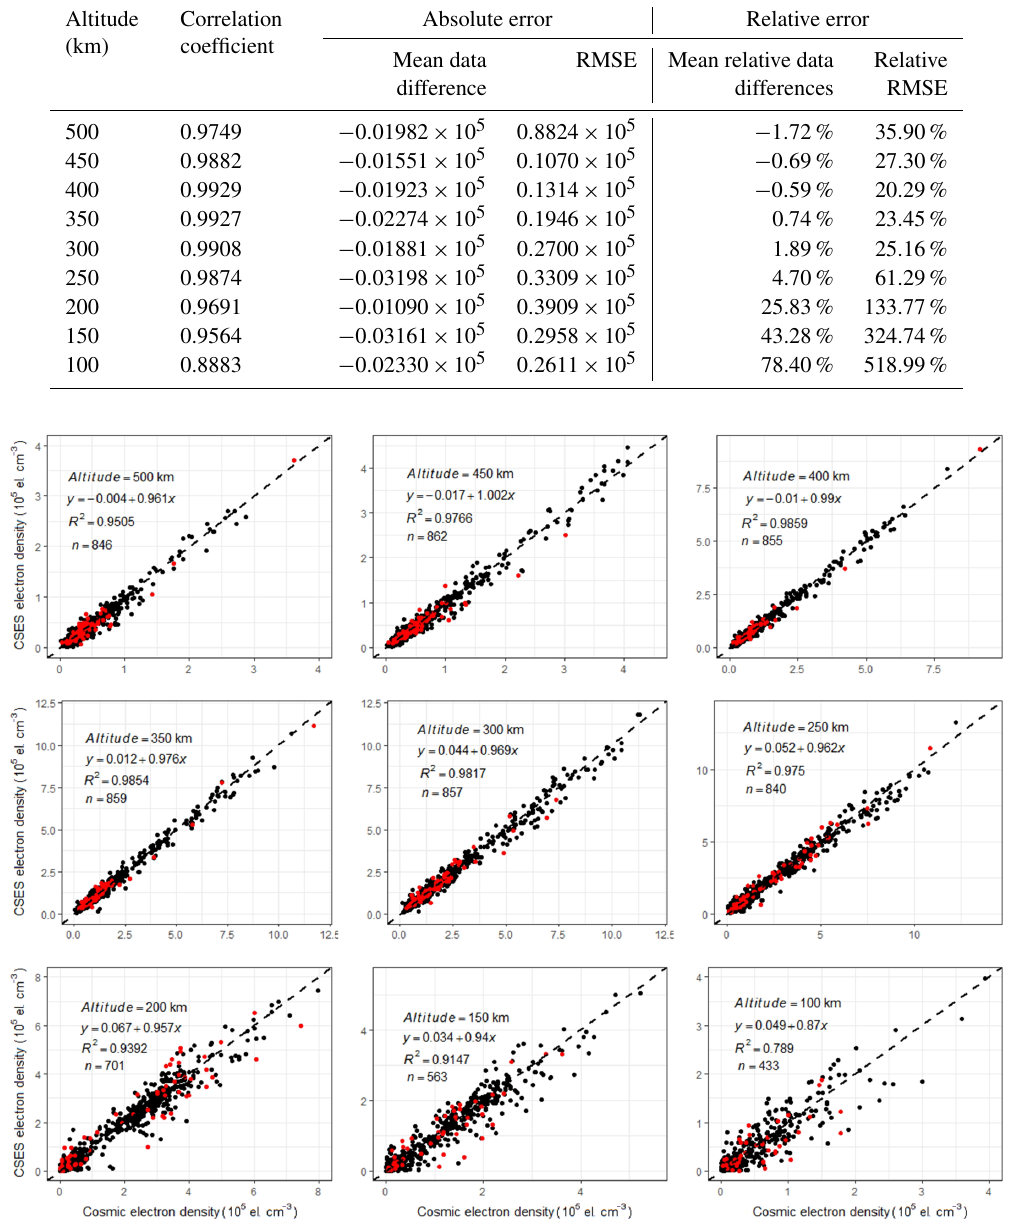
Figure 8. Scatter plots of data from matched profiles at different altitudes. The dashed line in Fig. 5 is the equal-value line with a slope of